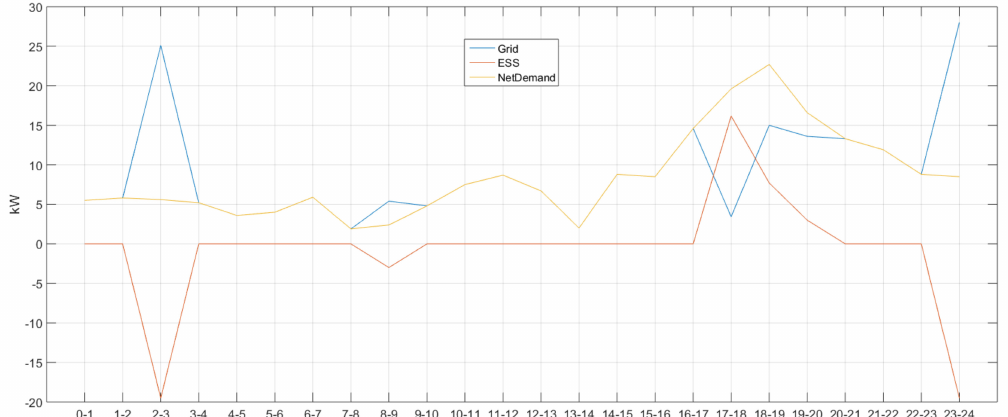
Figure 4. Simulation result when the conditional equation for peak control was